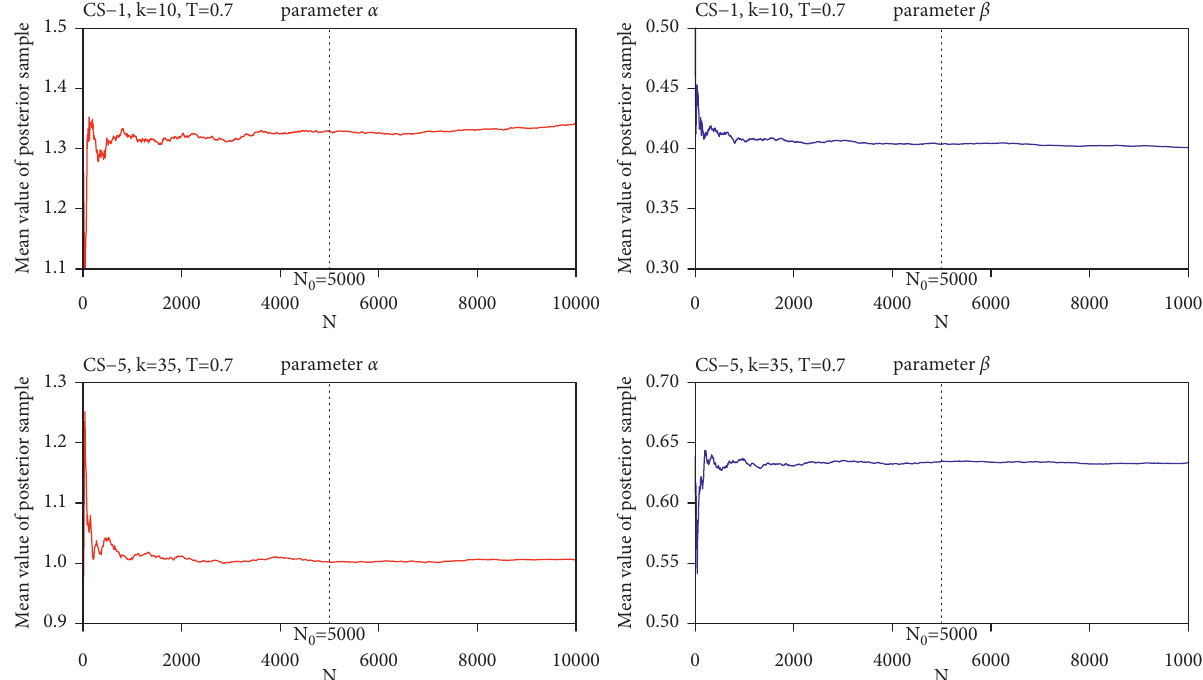
Figure 2: The sampling iterative trend plots of parameter ( α , β ) � ( 1 , 0 . 6 ) under different censoring schemes.